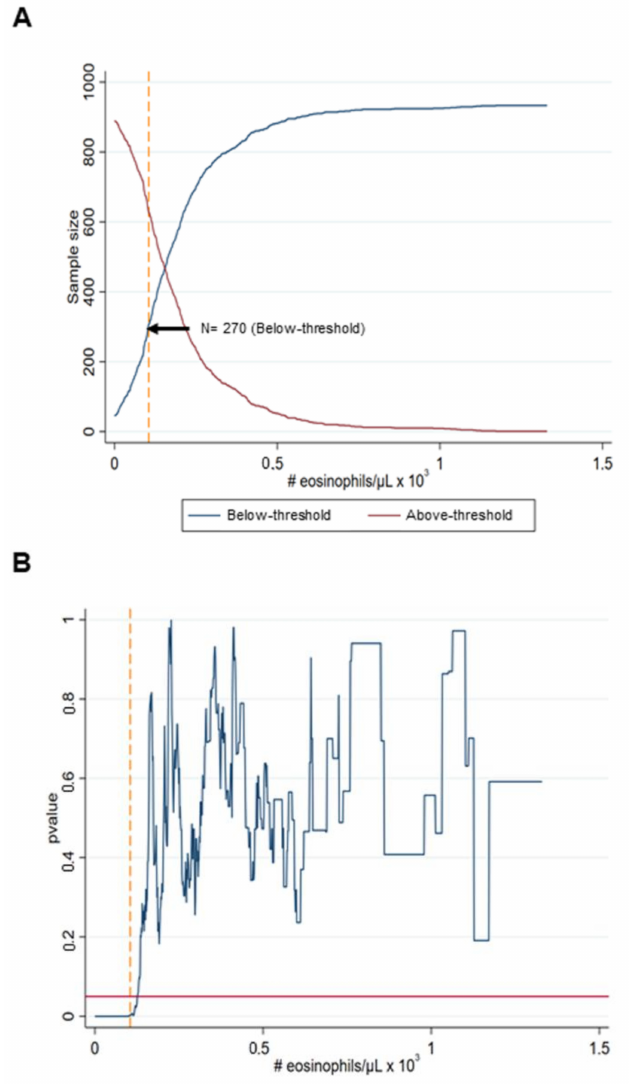
Figure 2. Selection of the eosinophil threshold for patient clustering. ( A ) Number of patients in the below-threshold cluster for increasing the eosinophil thresholds. The point indicated by the black arrow corresponds to the percentage of the patients’ threshold in the below-threshold, which led to the most balanced cluster sizes. ( B ) Statistical significance resulting from the Mann–Whitley U test as a measure by the corresponding p -value for varying thresholds (in terms of the percentage of patients belonging to the below-threshold cluster). The horizontal solid red line shows the statistical significance threshold p = 0.05, while the vertical yellow dashed line shows the optimal threshold of the eosinophil counts corresponding to the p